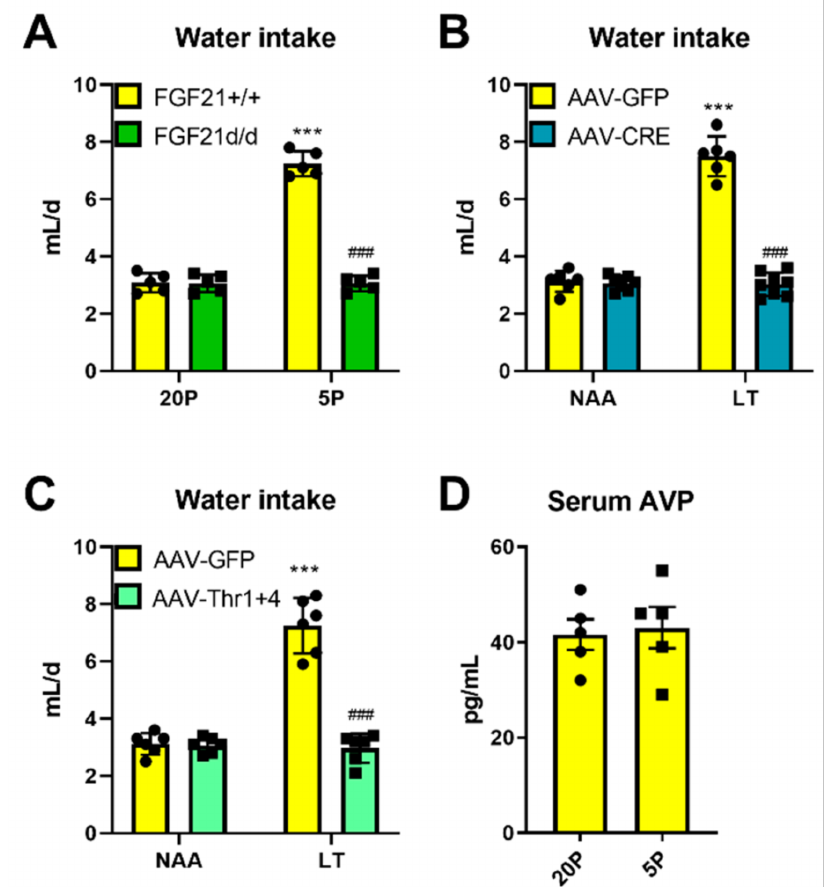
Figure 4. Liver-derived FGF21 is required for the hyperdipsic response to dietary AA restriction. ( A ): Water intake rate of wildtype (Fgf21+/+) and whole body knockout (Fgf21d/d) littermate mice in response to treatment with diets containing 20% calories from protein (20P) or 5% calories from protein (5P). Data are mean ± SEM ( n = 5 per group). Different than 20P: *** p < 0.001. Different than Fgf21+/+: ### p < 0.001. ( B ): Water intake of Fgf21fl/fl mice treated with a normal amino acid diet (NAA, 18% energy from amino acids) or with a diet low in Threonine but with matching total AA to diet NAA (LT). Mice were pre-treated (tail vein injection) with adeno-associated viruses to express the Cre-recombinase (AAV-CRE) or the green fluorescent protein (AAV-GFP) in a hepatocyte-selective manner. Data are mean ± SEM ( n = 6–8 per group). Different than NAA: *** p < 0.001. Different than AAV-GFP: ### p < 0.001. ( C ): Water intake of mice kept on NAA or LT diet following tail vein injection of adeno-associated viruses to transduce the liver to either express the yeast threonine biosynthetic enzymes Thr1 and Thr4 or GFP as a negative control. Data are mean ± SEM ( n = 6 per group). Different than diet NAA: *** p < 0.001. Different than AAV-GFP: ### p < 0.001. ( D ): Serum arginine-vasopressin levels of mice in response to treatment with diets containing 20% energy from protein (20P) or 5% energy from protein (5P). Data are mean ± SEM; n = 5 per group. Statistical analyses: Two-way measures ANOVA ( A – C ), student’s t -test ( D